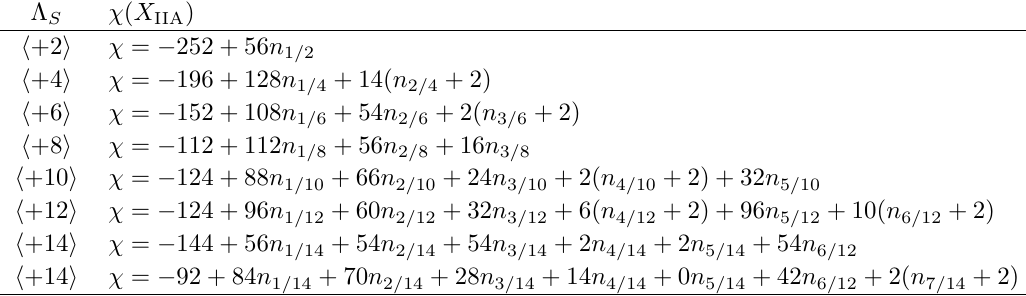
Table 6 . Euler number (cid:31) in terms of BPS indices n (cid:13) . n (cid:13) or ( n (cid:13) + 2) above is non-negative. For example, (cid:31) (cid:21) (cid:0) 196 when (cid:3) S = h +4 i . The last two lines show an example where Weyl-inequivalent sub-lattices of E 8 for for L [ (cid:0) 1] give di(cid:11)erent expressions of (cid:31) in terms of f n (cid:13) g